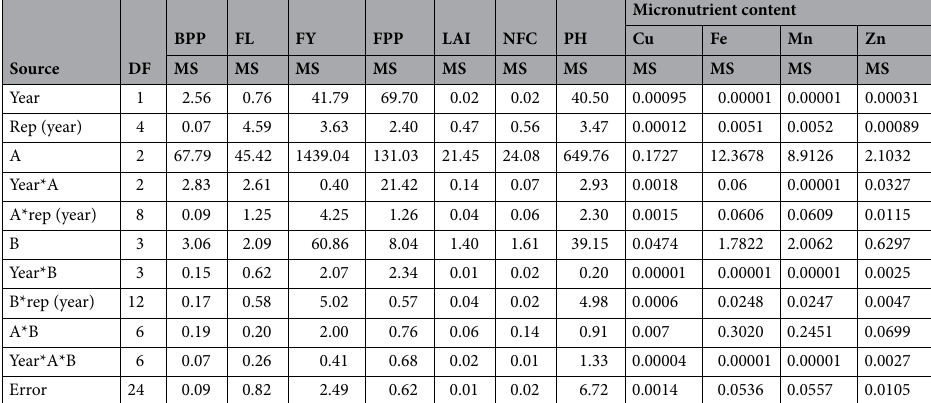
Table 6. Analysis of variance of growth, yield attributes, yield and nutrient concentration in eggplant. * Source source of variation, Rep replication, A main plot (NPK treatment), B sub-plot (MNENPK treatment), MS mean square, DF degree of freedom, BPP branches per plant, FL fruit length, FY fruit yield, FPP fruits per plant, LAI leaf area index, NFC number of fruits per cluster, PH plant